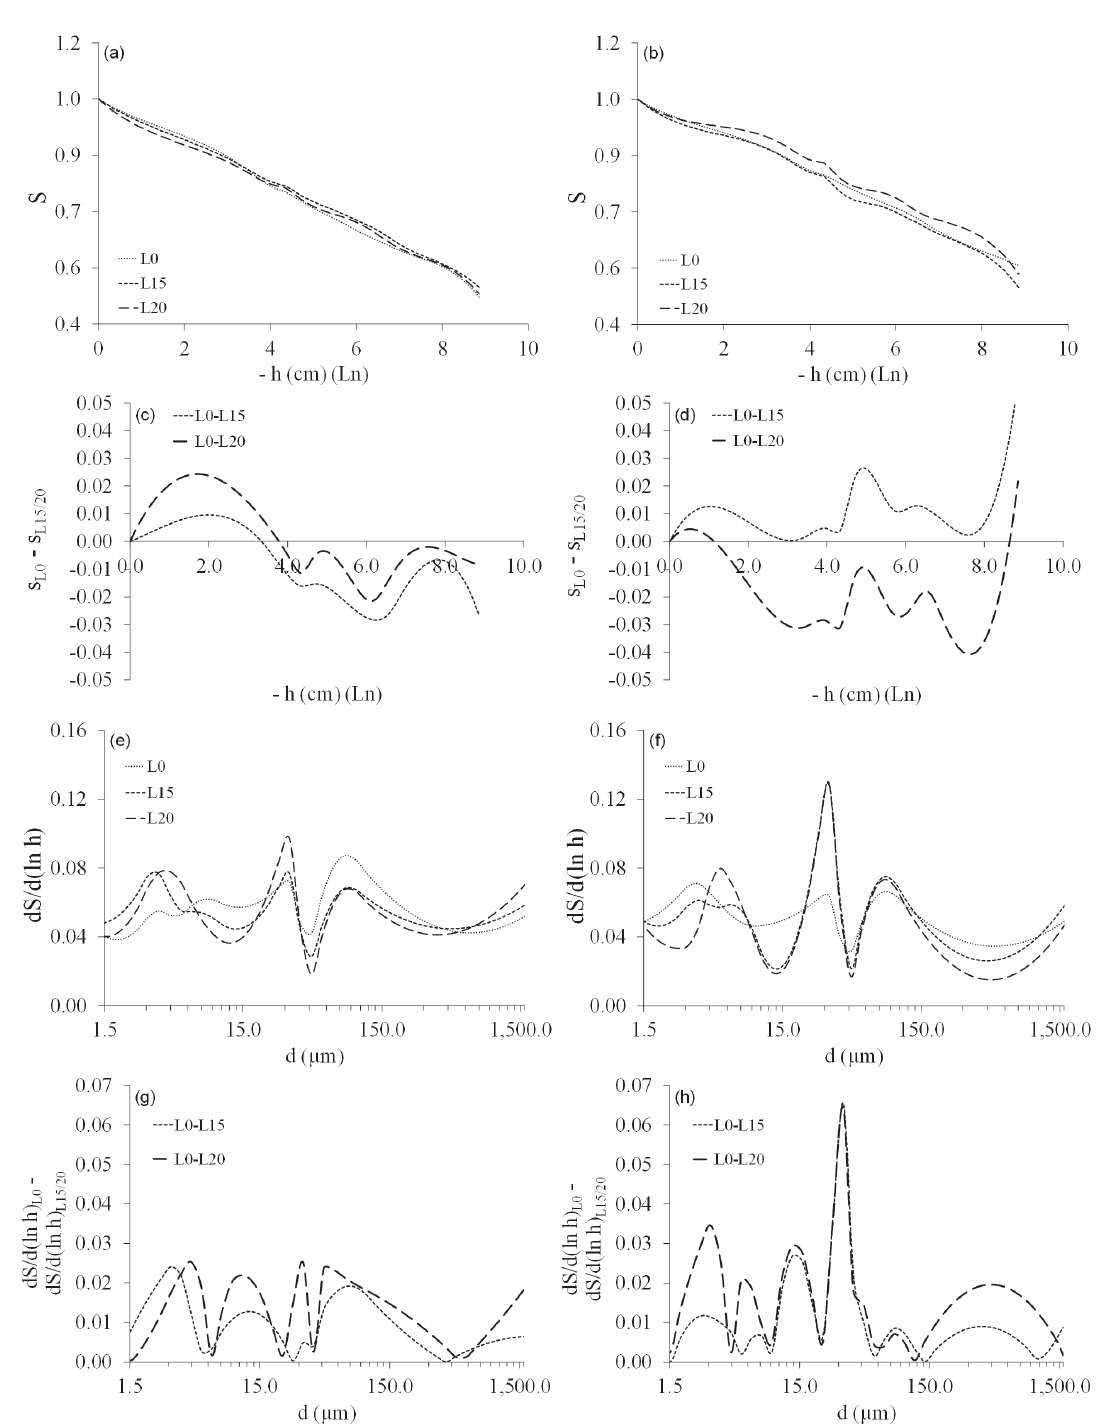
Figure 2 - Soil water retention curves (SWRC), absolute difference between SWRC obtained for L0 and the remaining treatments (L15 and L20), pore size distribution curves (PSDC) and absolute difference between PSDC obtained for L0 and the remaining treatments (L15 and L20) for 0-10 cm ( a , c , e , g ) and 10-20 cm ( b , d , f , h ) soil layers,